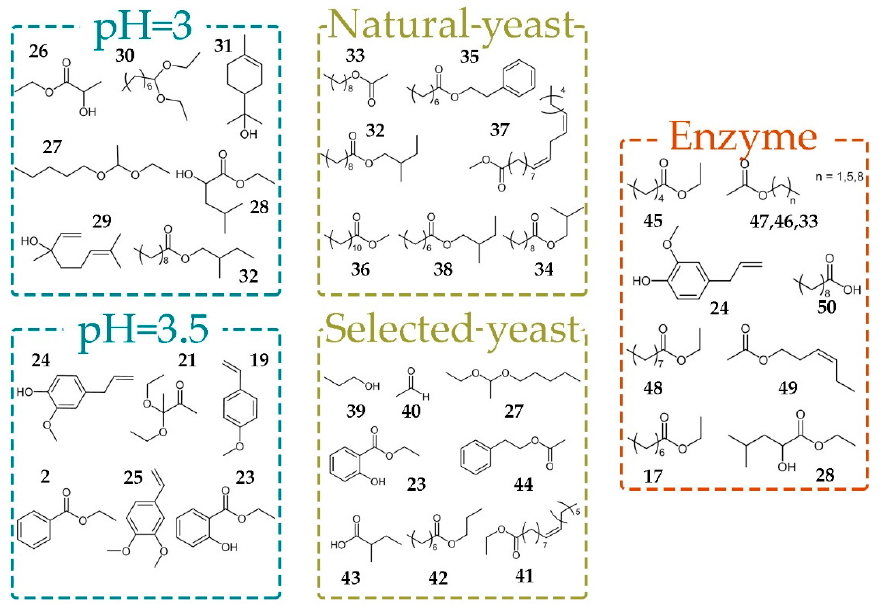
Figure 4. Metabolites important for discrimination between brandies produced under different fermentation conditions.